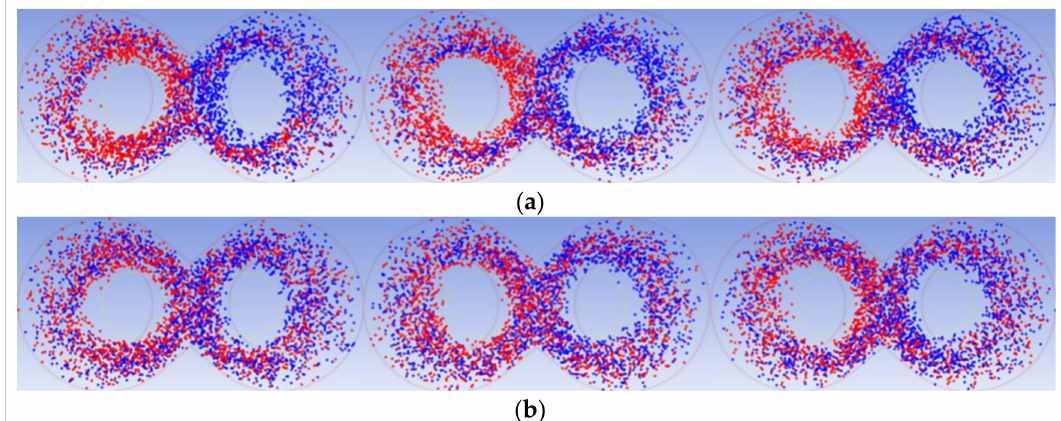
Figure 16. Particle distribution at 3, 10, and 40 s between the two chambers for the rotor ( a ) before and ( b ) after optimization.